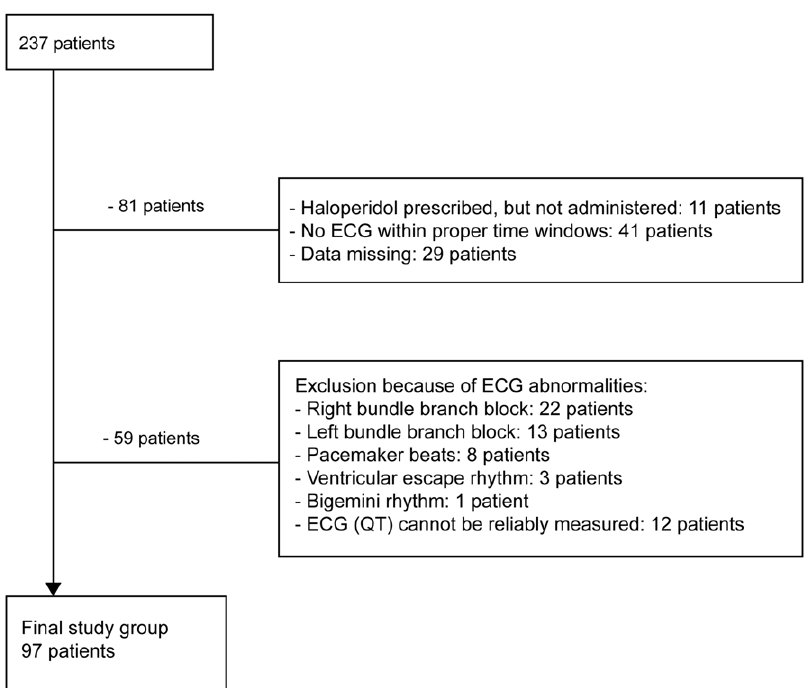
Figure 1. Flowchart of patient inclusion.